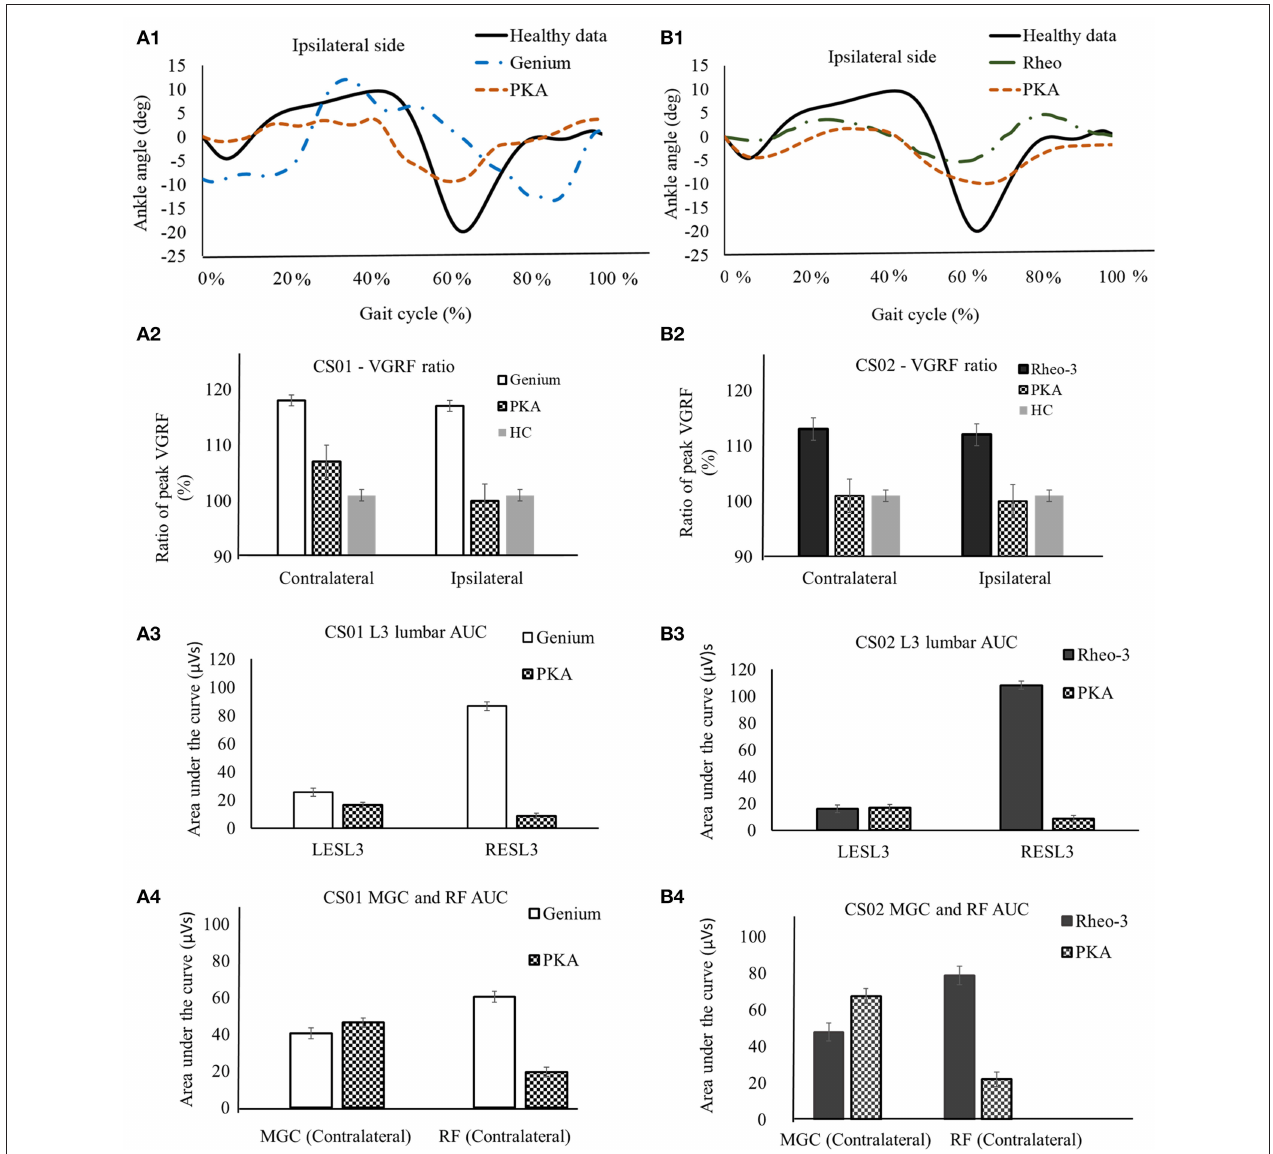
FIGURE 1 | A representative data showing comparison of biomechanics outcome metrics between MPK and PKA. Panels (A1–A4) are for participant CS01. (A1) compares the ankle joint kinematics between PKA, MPK1- (Genium), and healthy data (Winter, 1991) for the ipsilateral side for CS01. (A2) Shows comparison of the ratio of peak VGRF (Fz1/Fz2) during the stance phase between MPK-1 (Genium), PKA, and healthy data (Winter, 1991). It was observed that using the PKA led to a VGRF behavior closer to healthy limb on both the contralateral and the ipsilateral sides. (A3) EMG activation profile between MPK-1(Genium) and PKA at right and left side L3 erector spinae muscles in low back. The EMG activation profile was indexed as area under the curve (AUC) of the EMG signal. It can be observed that using PKA reduces the asymmetry in EMG activation between the LES-L3 and the RES-L3 muscles. (A4) EMG activation (AUC) for lower extremity muscles MGC and RF on contralateral side. It was observed that using the PKA lead to higher activation in the MGC and reduced activation in the RF on the contralateral side. Panels (B1–B4) are for participant CS02. (B1) compares the ankle joint kinematics between PKA, MPK2- Rheo-3, and healthy data (Winter, 1991) for the ipsilateral side for CS02. (B2) Comparison of the ratio of peak VGRFs during the stance phase between MPK-2 (Rheo-3), PKA, and healthy data (Winter, 1991). It was observed that using the PKA led to a VGRF behavior close to healthy limb on both, the contralateral and the ipsilateral sides. (B3) EMG activation profile between MPK-2 (Rheo-3) and PKA at right and left side L3 erector spinae muscles in low back. The EMG activation profile was indexed as area under the curve (AUC) of the EMG signal. It can be observed that using PKA reduces the asymmetry in EMG activation between the LESL3 and the RESL3 muscles. (B4) EMG activation (AUC) for lower extremity muscles MGC and the RF on contralateral side. It was observed that using the PKA lead to higher activation in the MGC and reduced activation in the RF on the contralateral side.